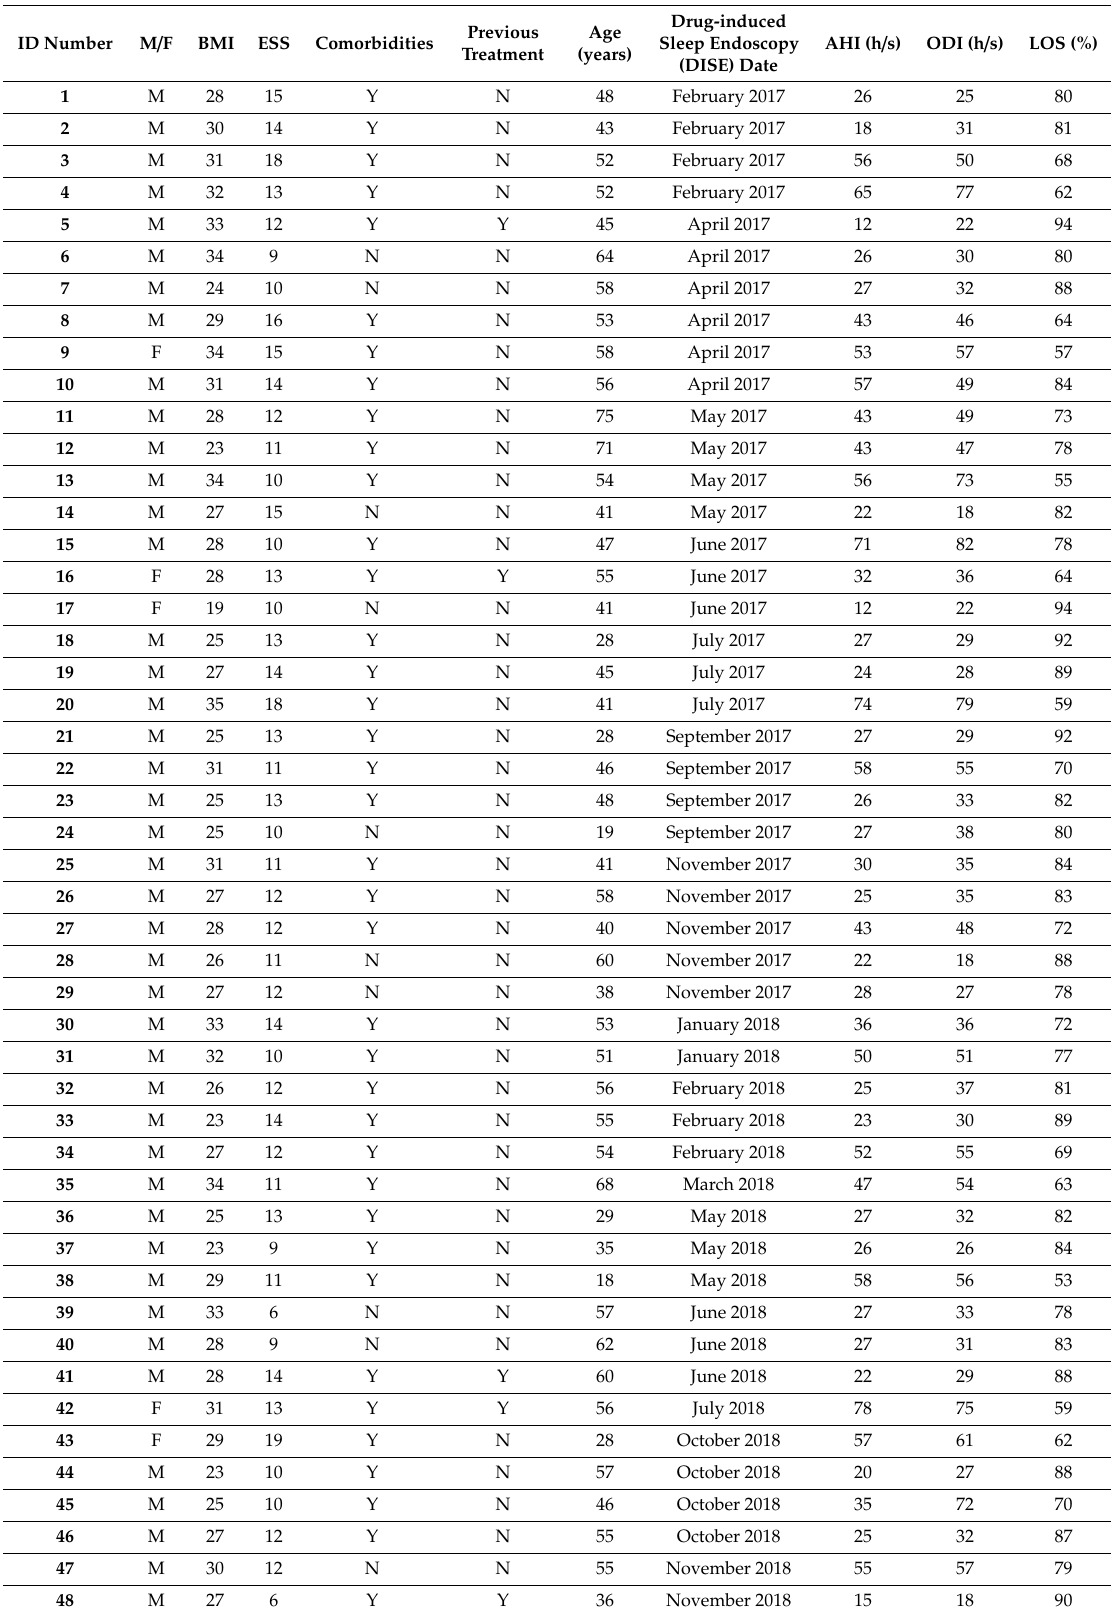
Table 1. Patient